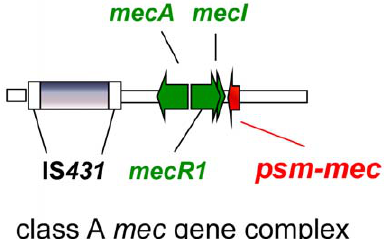
Figure 1. Conserved location of the psm-mec gene in the class A mec gene complex. The class A mec gene complex contains the core genes of the SCC mec element in the order IS431- mecA - mecR - mecI . Downstream of mecI , the psm-mec gene is encoded in opposite direction as a conserved part of this complex.